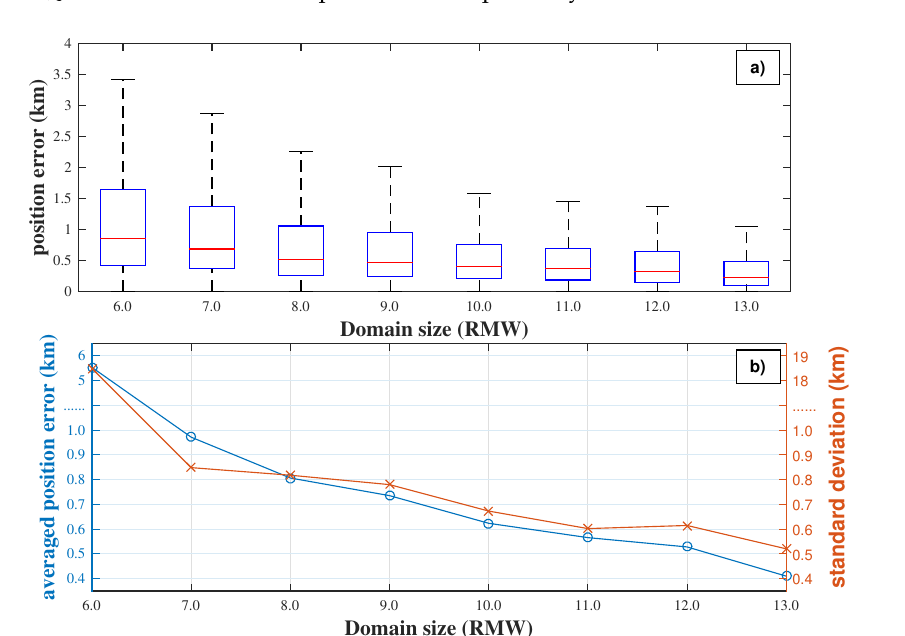
Figure 2. The statistics of position error according to normalized domain size. ( a ) the boxplot of position error. ( b ) the group averaged position error (blue line and circles) and standard deviation (red line and crosses) in each